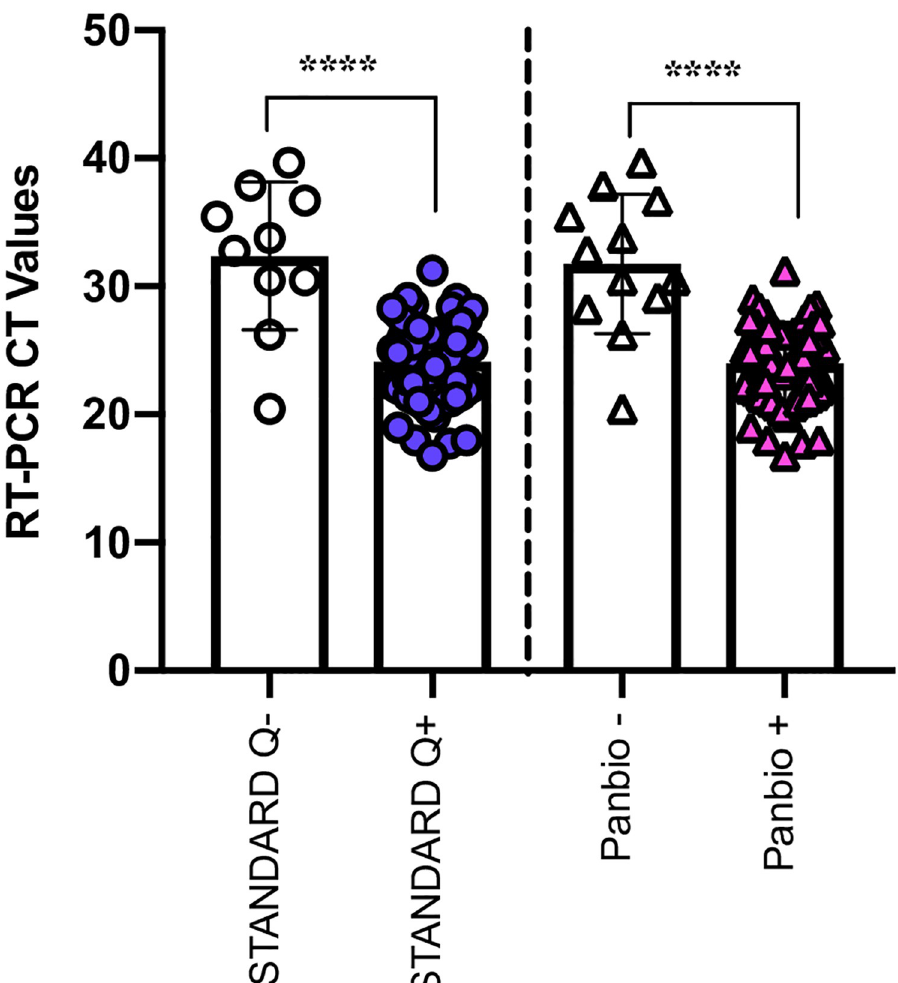
Fig 1. Comparison of CT values in participants who tested positive for SARS-CoV-2 using RT-PCR, grouped according to each Ag-RDT positive and negative results ( ���� p < 0.0001).